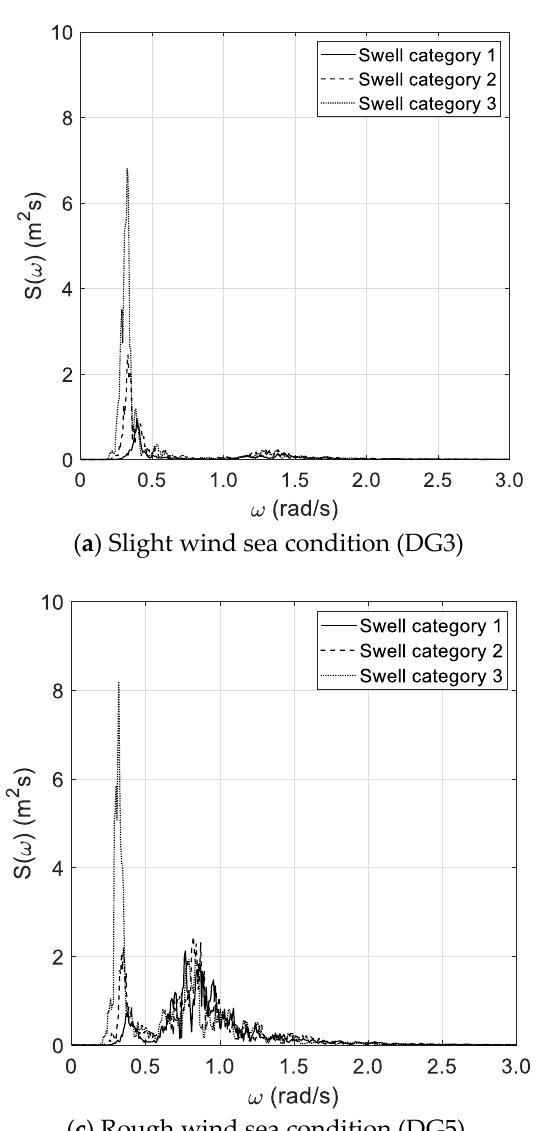
Figure 4. Spectral analysis (Thomson)—short duration with low frequency resolution.